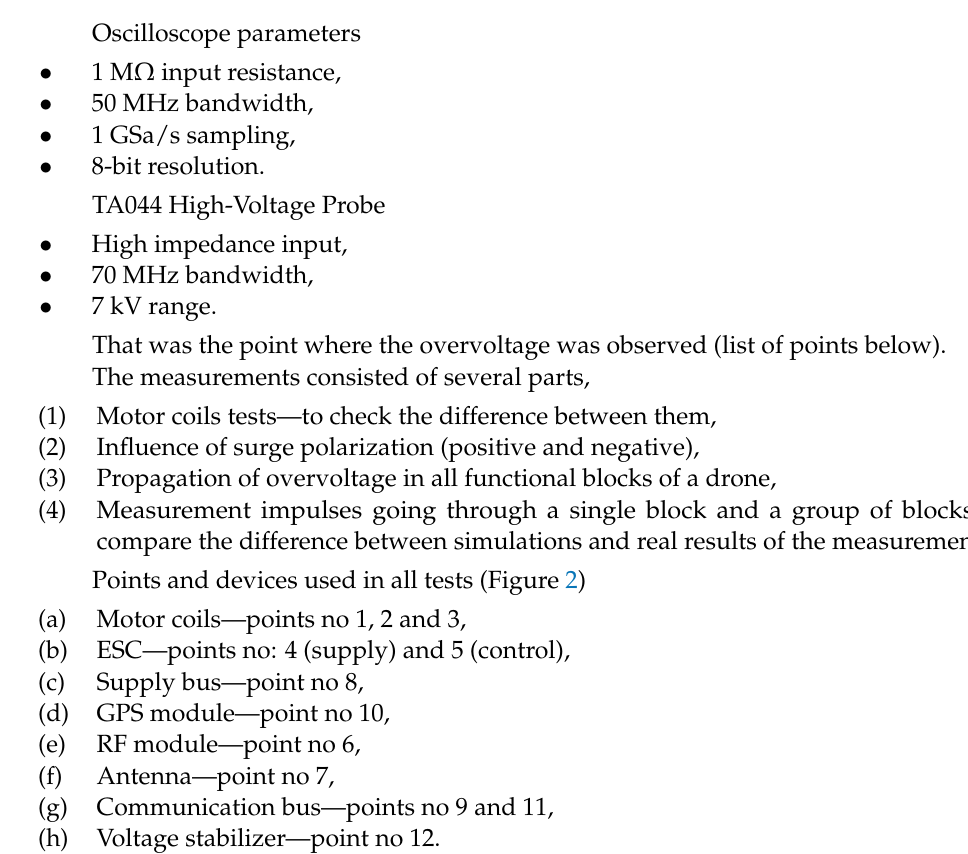
Figure 3. Simplified measurement scheme of drone components.